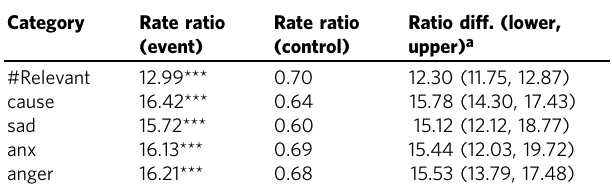
Table 2 Change in the number of relevant tweets and linguistic features.